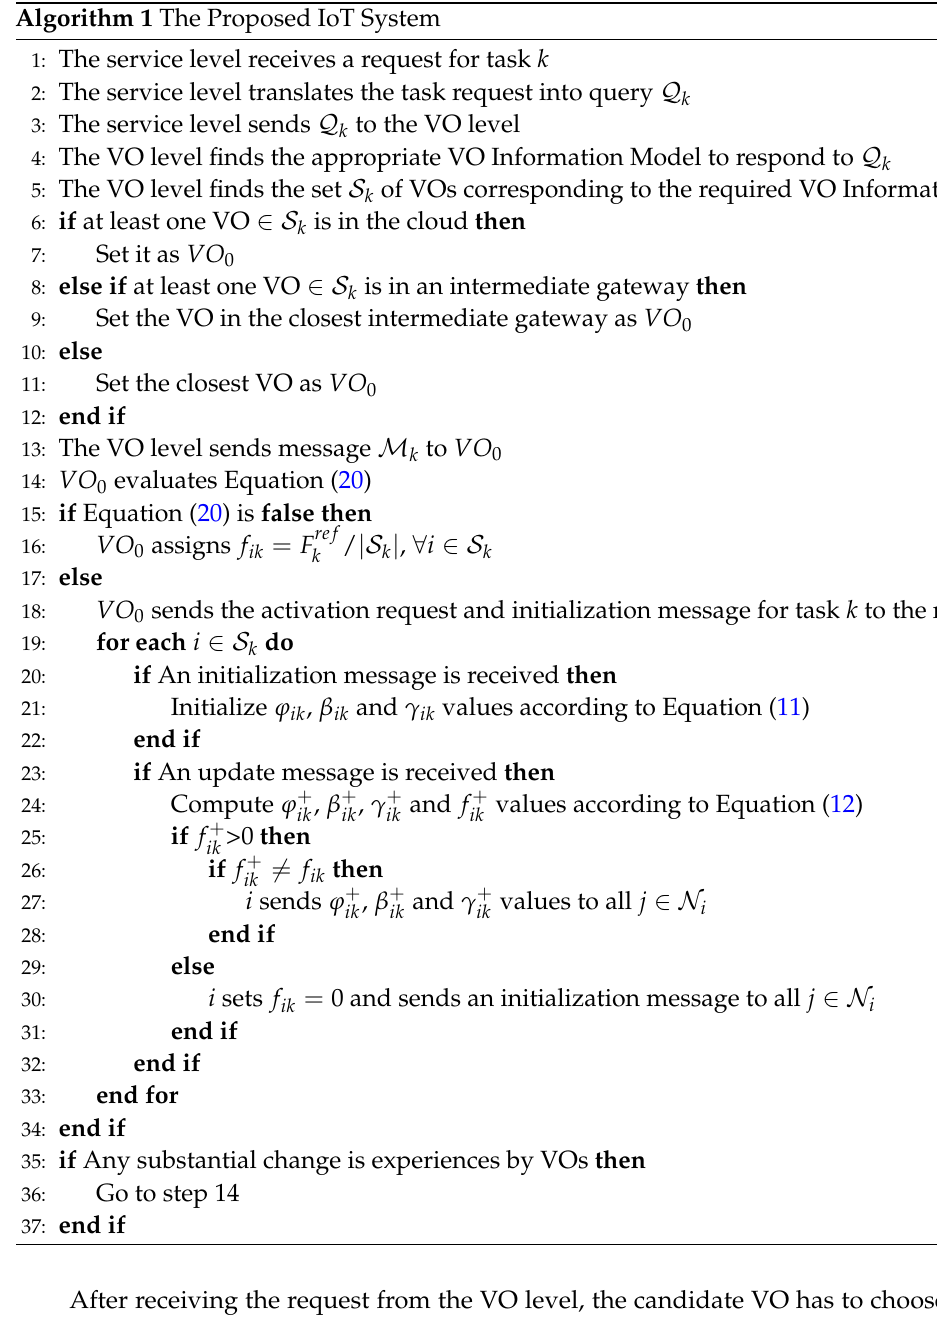
Algorithm 1 The Proposed IoT